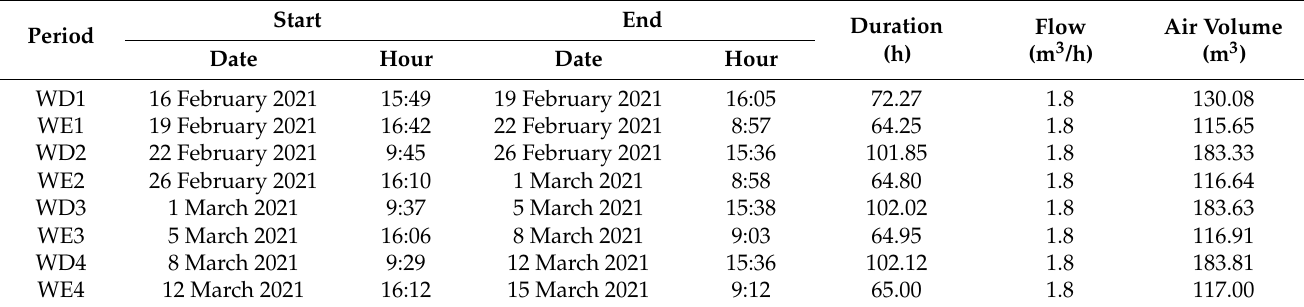
Table 1. Sampling periods and details of the 3-cascade